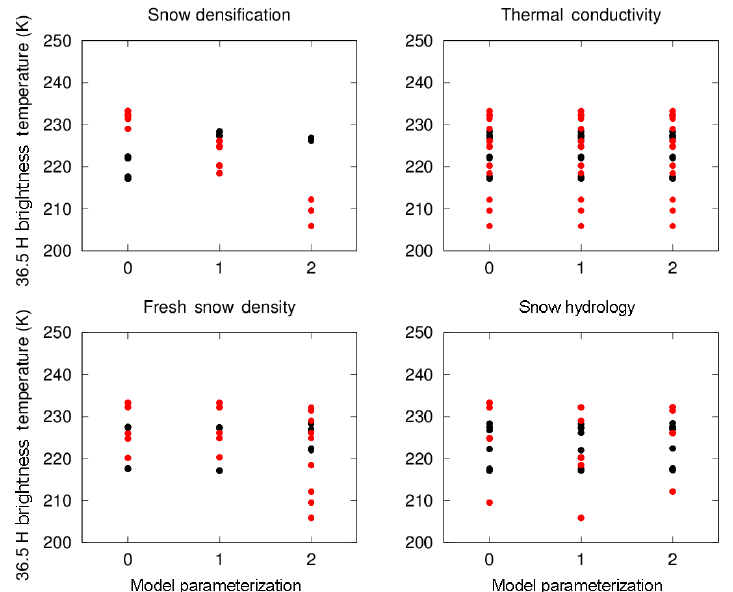
Figure 7. Cluster analysis of brightness temperature simulated by MOSES microstructure and empirical MEMLS for 1 February 2012 (black dots) and 1 May 2012 (red dots) according to model parameterization choices. Brightness temperature simulations are split according to the different representations for each process representation. Values 0, 1, 2 relate to parameterisations given in Essery et al. (2013) and as described in Sect. 2.1. Where distinct clusters occur that differ between parameterisations, this indicates sensitivity to the parameterization. Table 9. Maximum difference in brightness temperature in K (H-pol/V-pol) due to 63 snowpack parameterisations for each unscaled snow microstructure evolution function (2011–2012 season). DMRTML MEMLS HUT less very IBA EMP H87 R04 K10 SNT 50/63 148/169 88/113 126/153 27/34 26/33 28/36 MOS 22/15 41/45 24/25 33/54 20/11 SNI